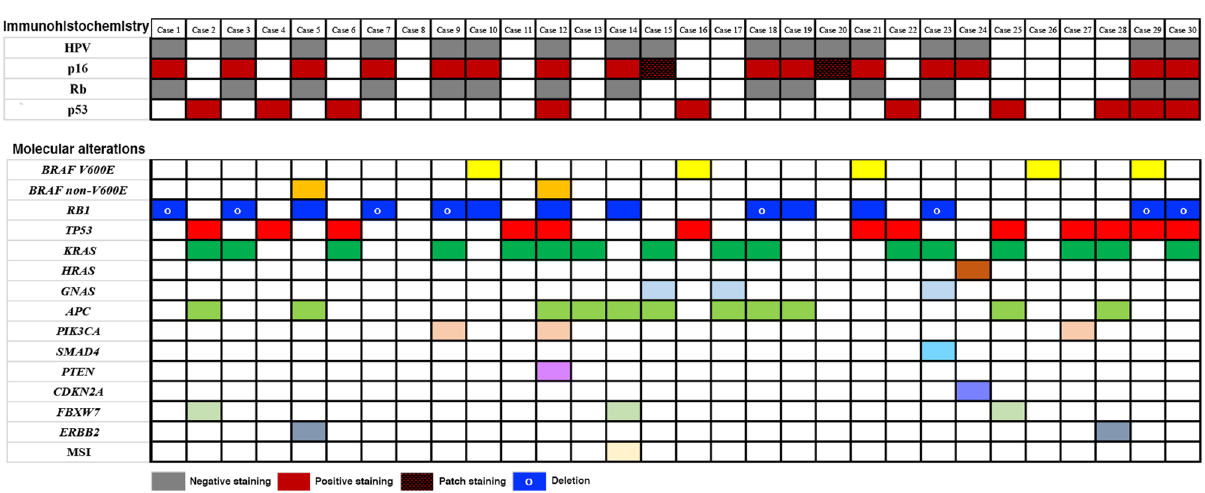
Figure 2. Heat map describing immunohistochemical results and somatic mutations identified in each case. Each row represents one case, and each row represents one gene. The above bar graph demonstrates the incidence of corresponding gene